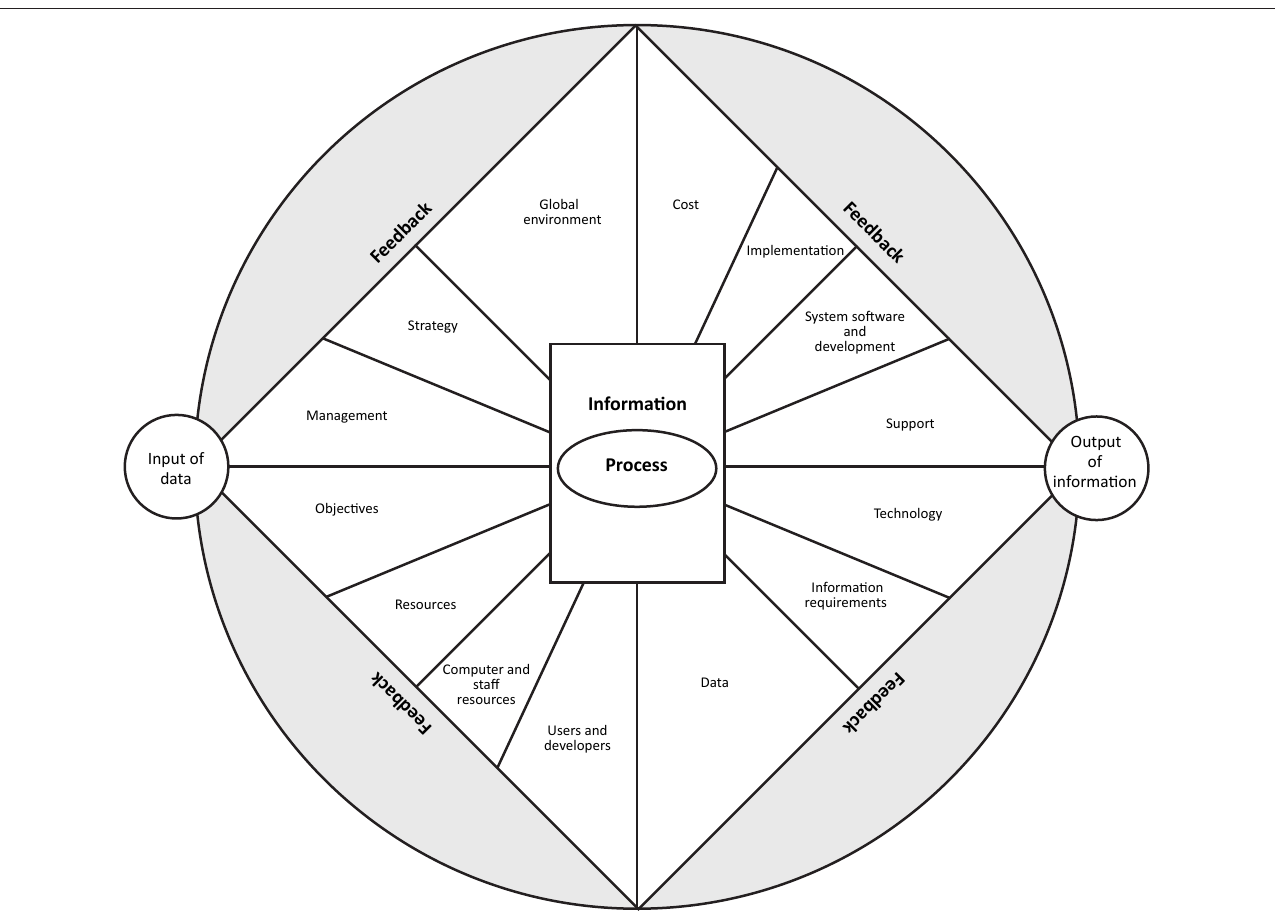
FIGURE 1: Challenges in an Executive Information System in